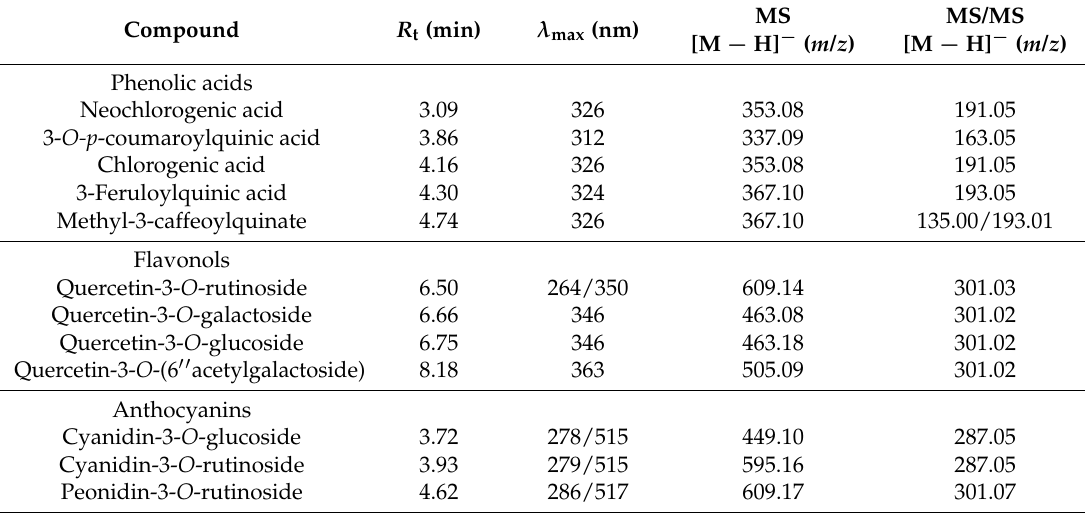
Table 1. Phenolic compounds identified by LC-MS QTof in juice plum